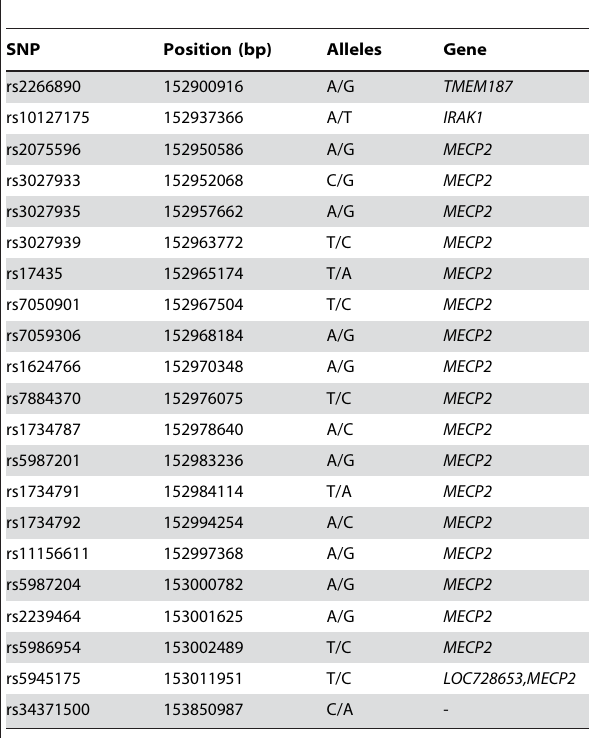
Table 1. SNPs genotyped in the MECP2 region in SLE patients and